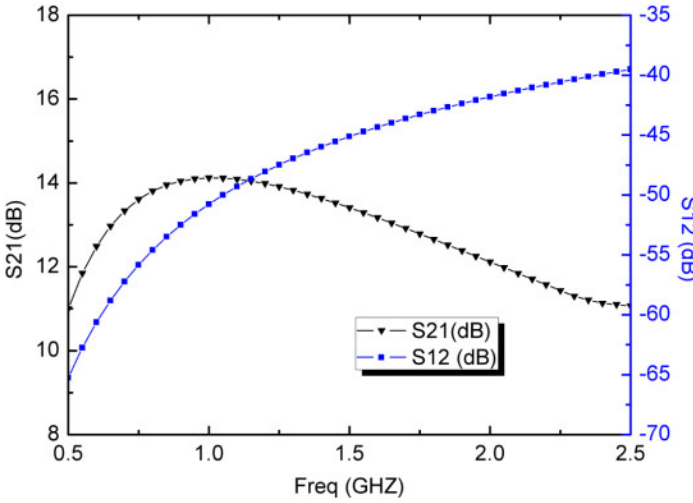
Figure 7. Simulated S21 and S12 of the wideband LNA.